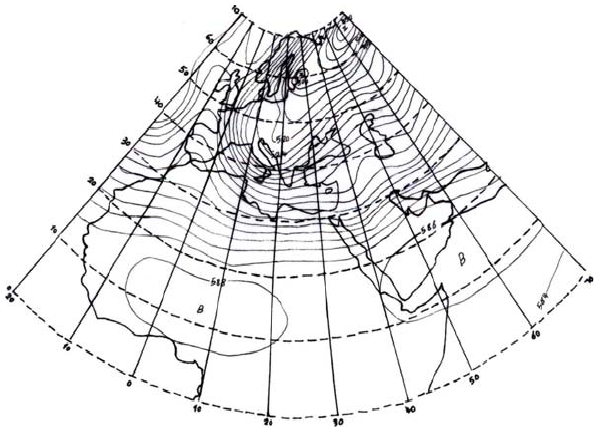
Fig. 17. The pattern of the streamlines and geopotential heights at